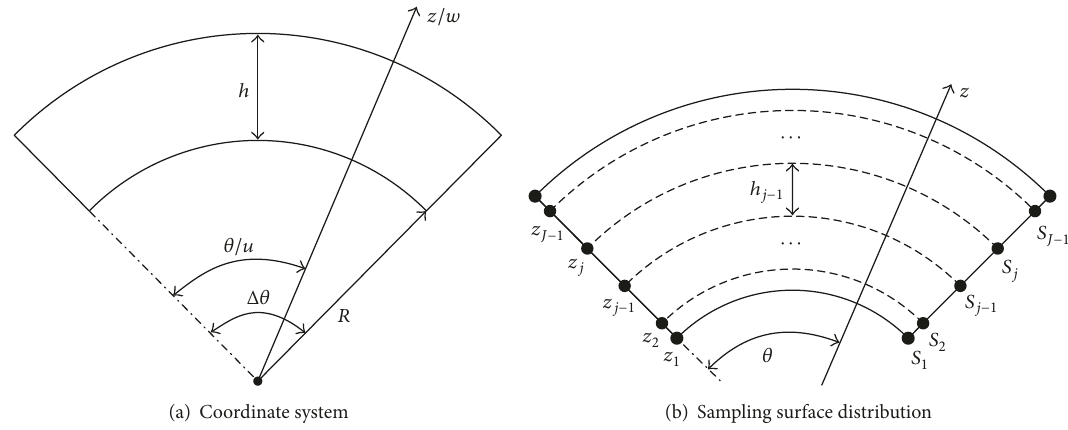
(b) Sampling surface distribution Figure 1: Geometry and reference system for a curved beam and the diagrammatic sketch of sampling surface